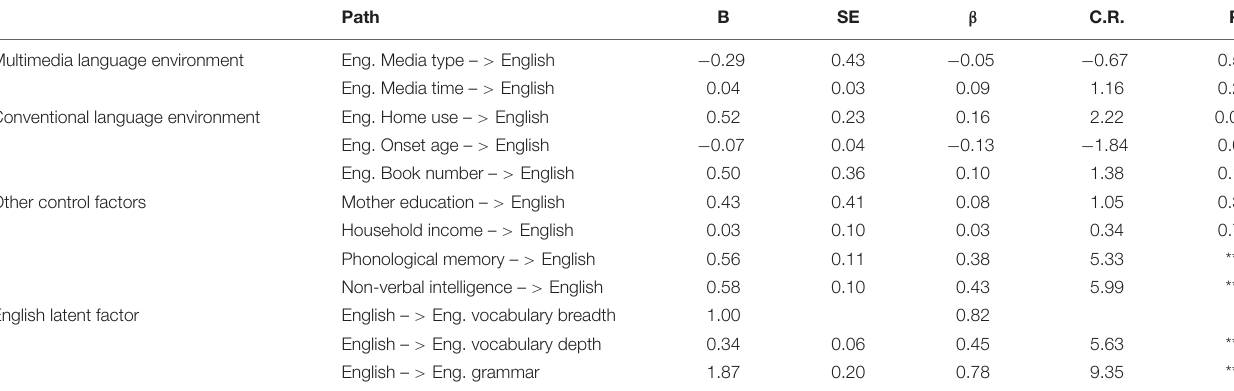
TABLE 3 | Results of structural equation modeling on English language outcomes. Path B SE